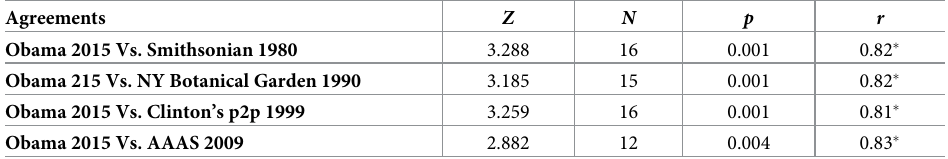
Table 4. Comparisons of the effects of Obama’s 2015 approach with previous U.S. contacts with Cuban scientific authorities on Cuba–U.S. joint productivity. Agreements Z